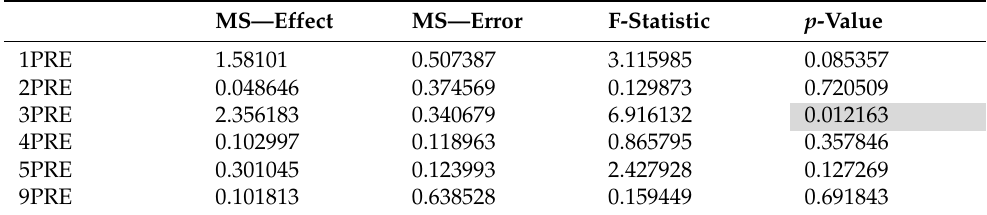
Table 2. Levene nonparametric test for the pretest.